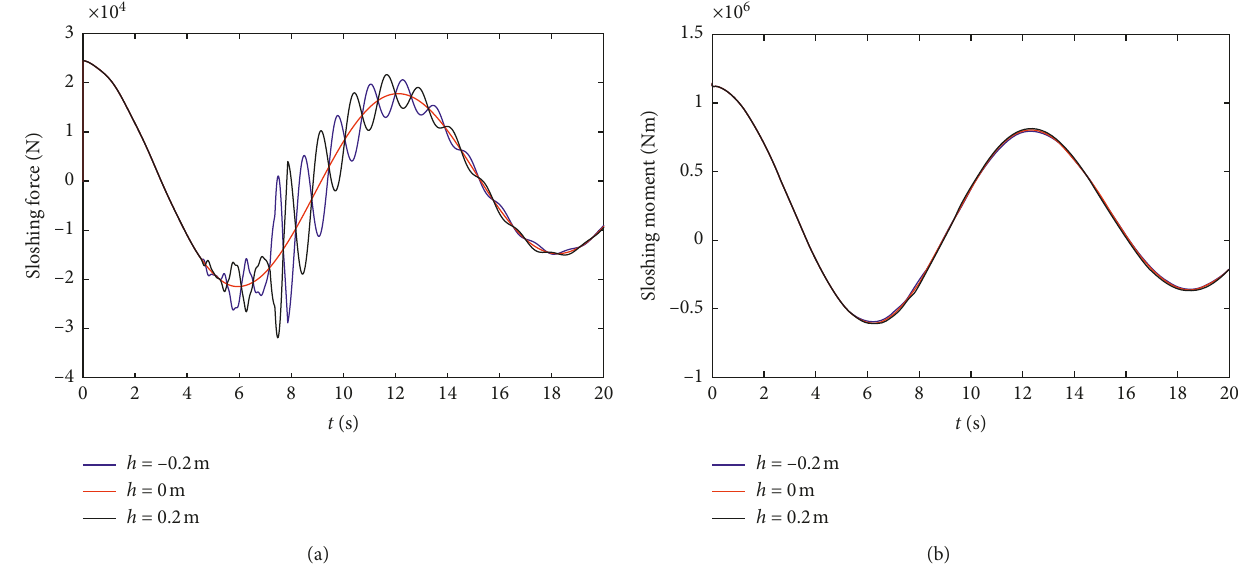
Figure 14: Sloshing force and moment during vehicle acceleration for a � 0 . 1 g